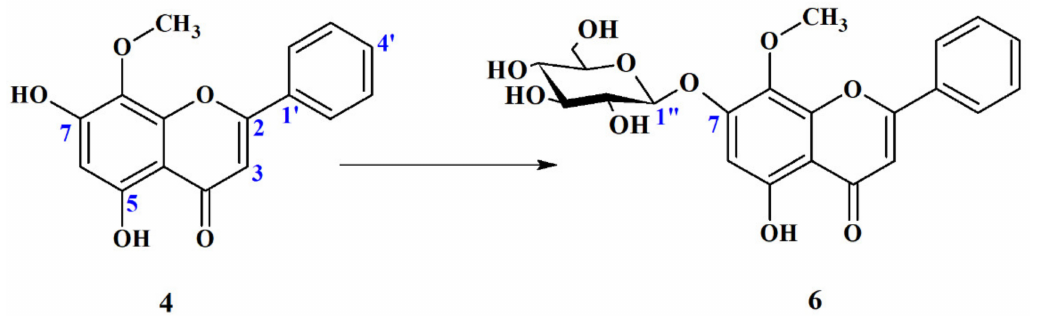
Figure 7. Biotranformation of wogonin ( 4 ) to its 7- O -glucoside ( 6 ) by: Absidia coerulea AM93, A. glauca AM177, A. glauca AM254, Beauveria bassiana AM278, Cunninghamella japonica AM472 and Mucor hiemalis